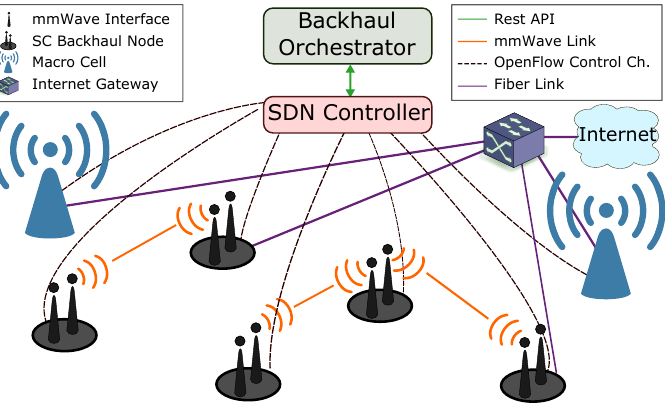
Figure 2. The system architecture of an Software Defined Networking (SDN)-based mmWave backhaul heterogeneous